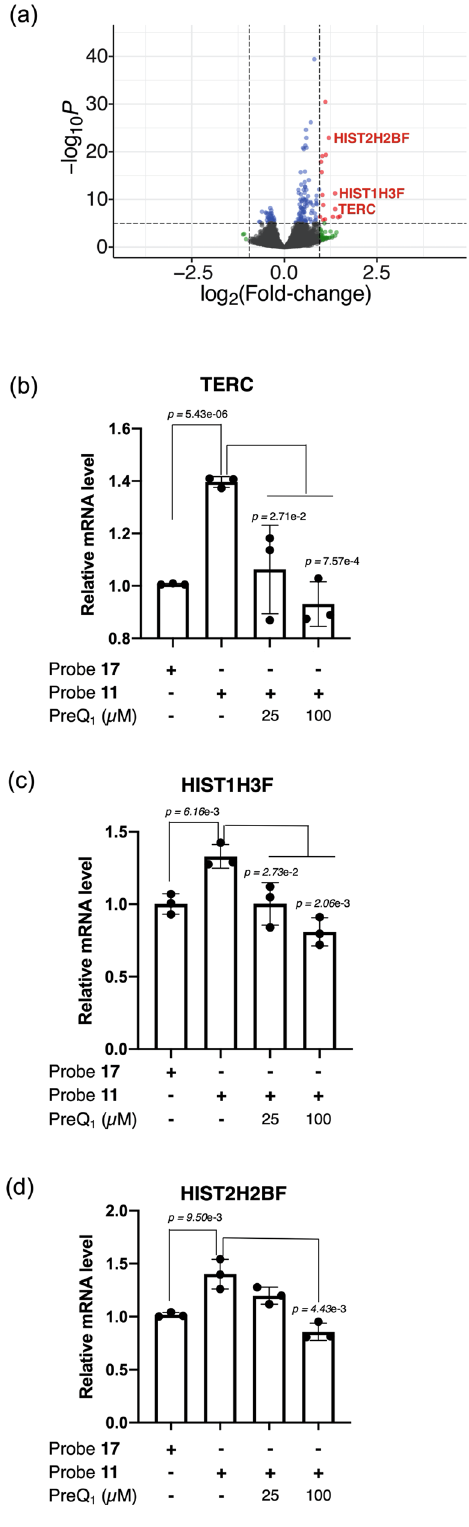
Fig. 7 The enrichment of endogenous human transcripts with 11. a Volcano plot of differential expression (DeSeq2) analysis between compound 11 and 17 treated samples ( n = 4 for 11 and n = 3 for 17 ). p = adjusted p -value. Histograms generated through RT-qPCR representing the relative level of b TERC, c HIST1H3F, and d HIST2H2BF in 11 and 17 treated samples. Data are presented as the mean ± SEM ( n = 3) of three independent experiments. Statistical signi fi cance was calculated by two- tailed t -test analysis. Source data are provided as a Source Data